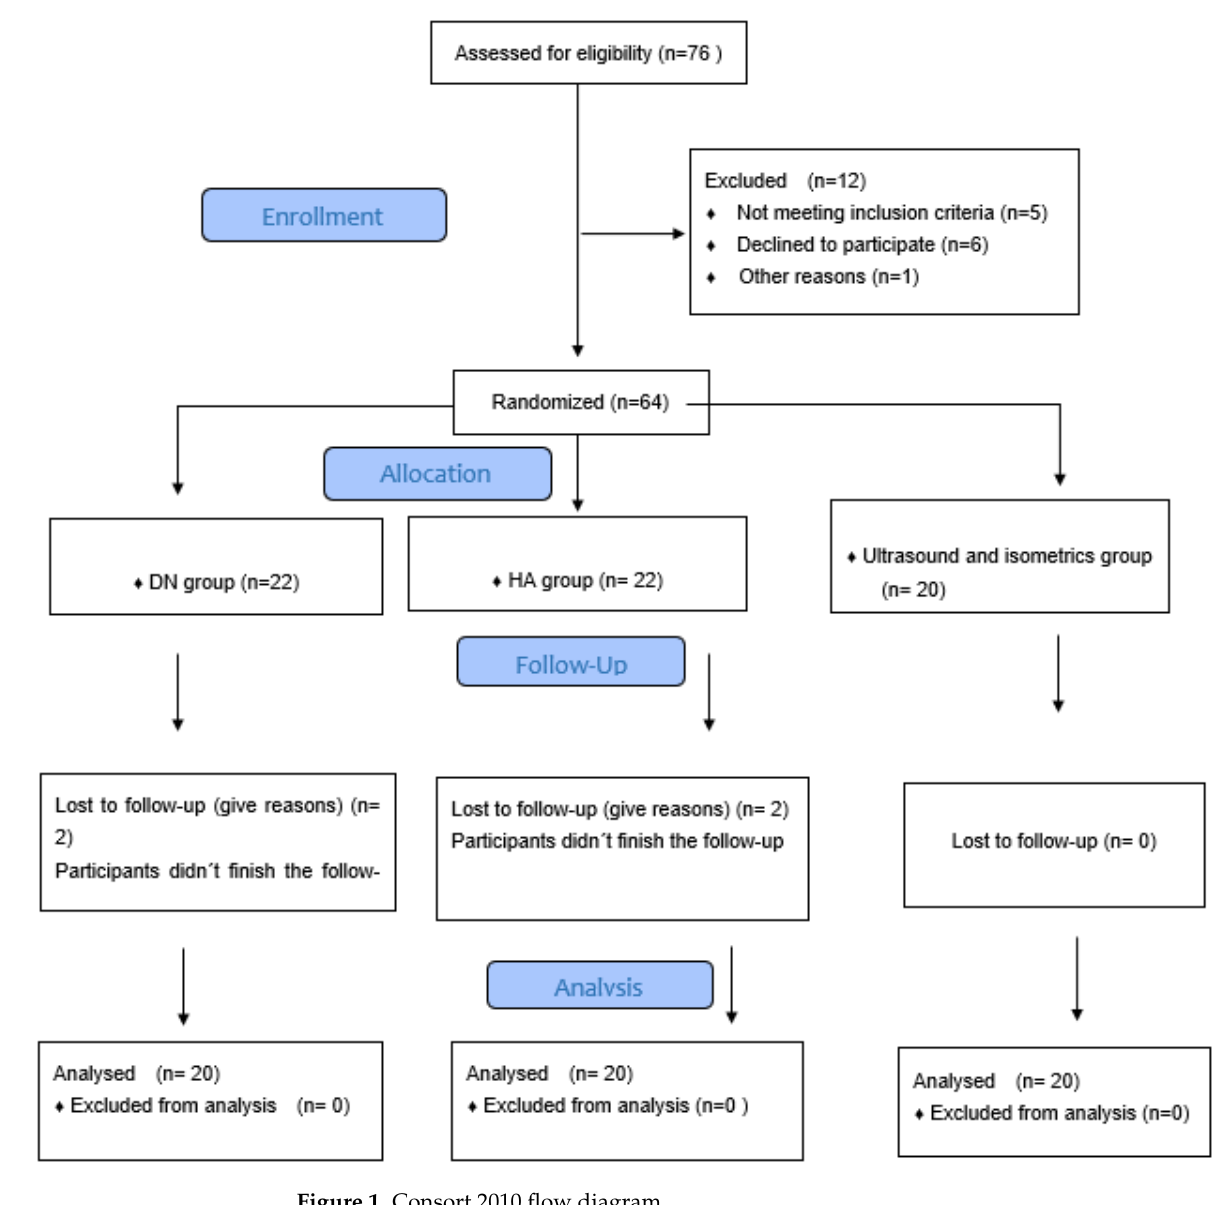
Figure 1. Consort 2010 flow diagram.